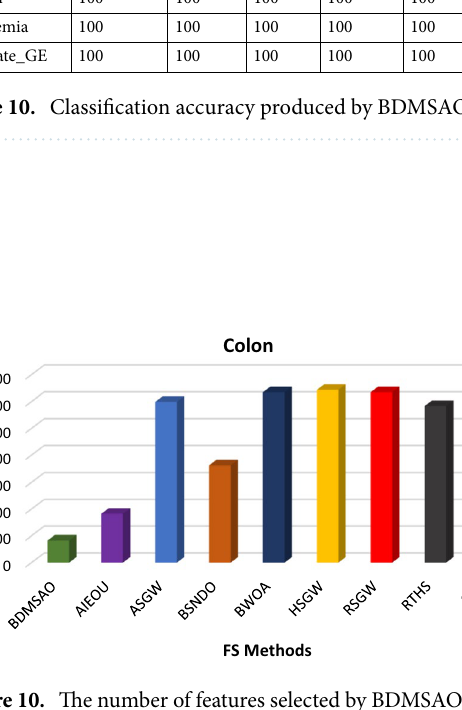
Figure 10. The number of features selected by BDMSAO and other FS methods on the Colon